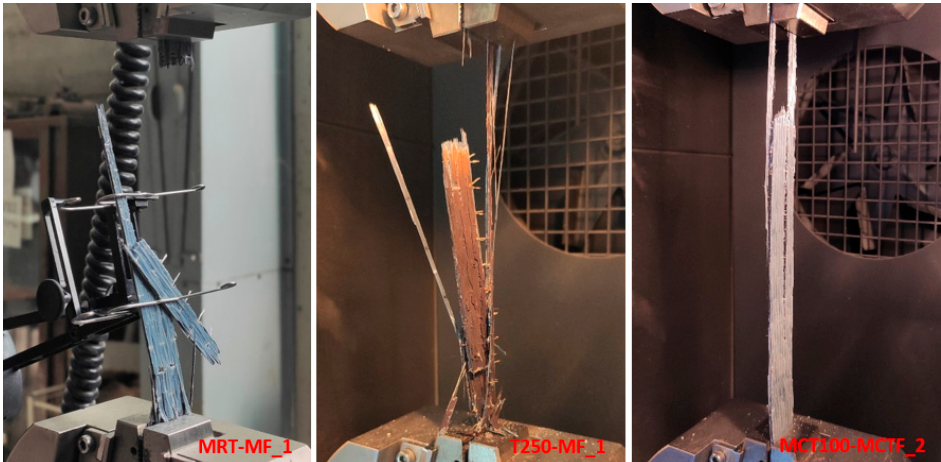
Figure 6. Mode of failure of the specimens.